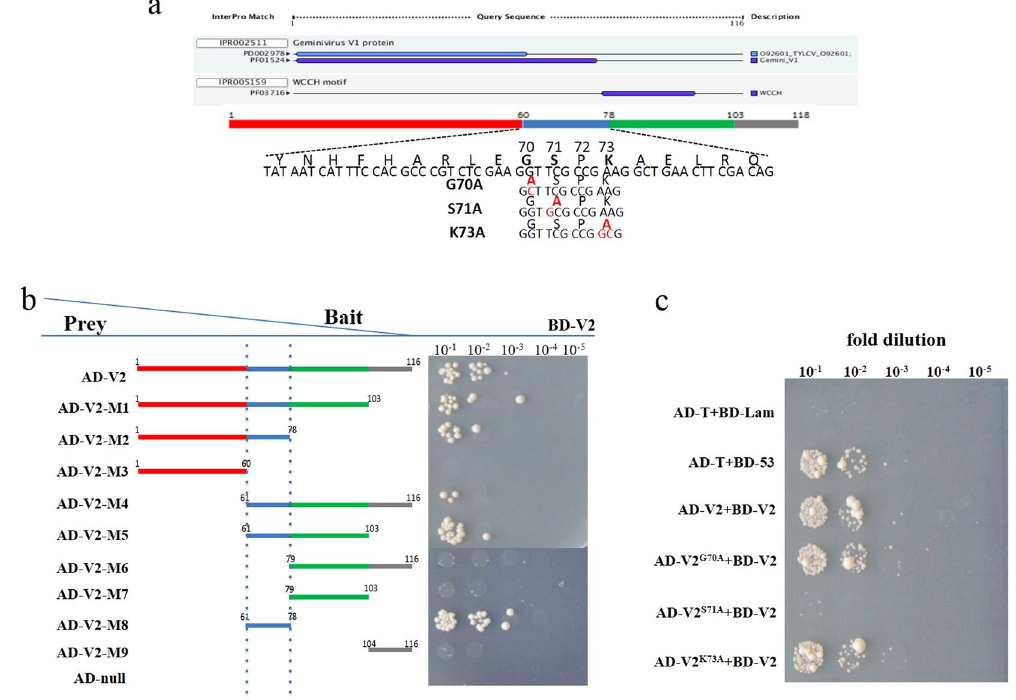
Figure 2. Identification the essential motif and site responsible for the self-interaction of V2. ( a ) Schematic representation of the motif and sites of TYLCV V2 based online prediction. ( b ) Schematic representation of the truncated mutants of V2 and yeast-two-hybrid analysis of the interactions with V2. ( c ) Identification of the interaction between the wide-type V2 and the site-directed mutants V2 G70A , V2 S71A , V2 K73A in a yeast two- hybrid